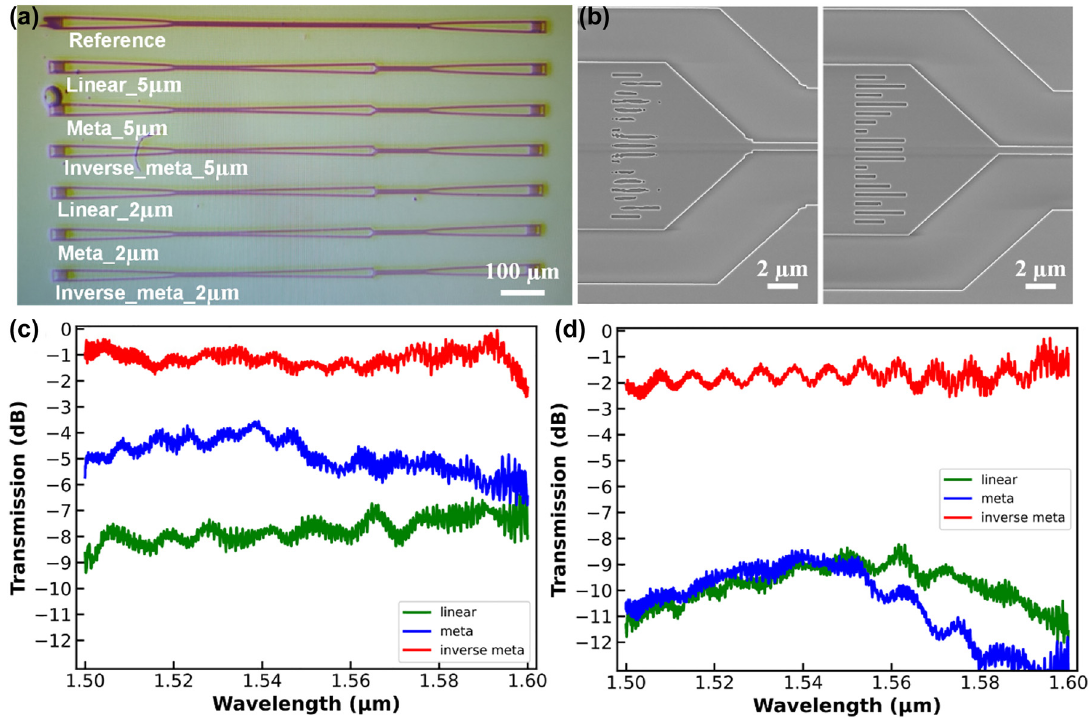
Figure 5: Experimental measurement of the fabricated devices. (a) Optical microscopic picture of the fabricated devices. (b) Scanning electron microscope (SEM) image of the fabricated 8 μ m mode-size converter with and without inverse design. The experimentally measured transmission over the entire C band for devices with length of 8 μ m (c) and 5 μ m (d),